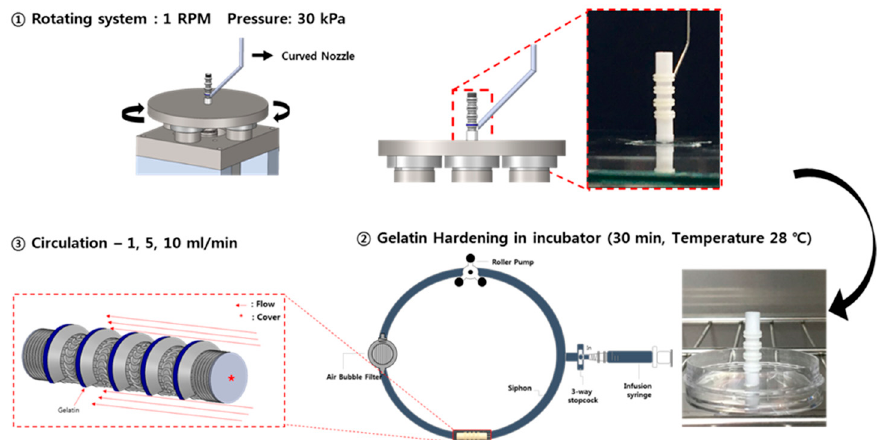
Figure 5. Experimental process using a circulation mock-up